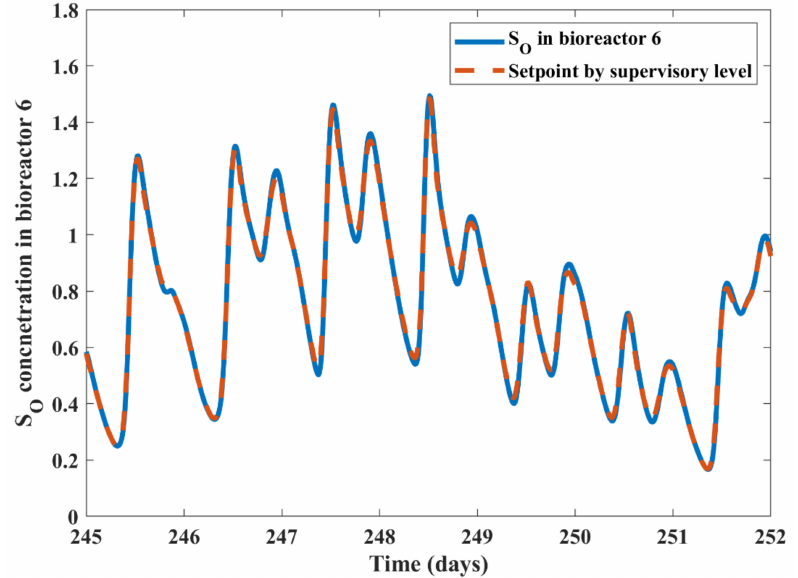
Figure 4. Dissolved oxygen tracking in the sixth reactor